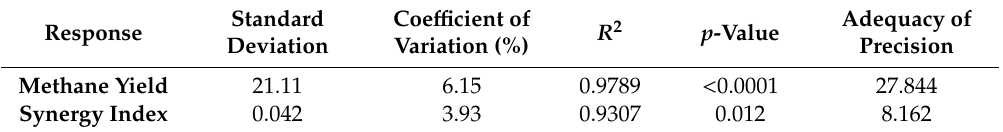
Figure 2. Methane yields ( A ) and synergy indices ( B ) determined on days 10, 20, and 30 of the BMP experiments. The CM: FW: PM mixing ratio (total solids basis) for each BMP run is given in parentheses below the corresponding run number. The red dashed line in panel ( B ) indicates where the synergy index is 1. Error bars indicate standard deviations ( n = 3). Table 3. Statistical significance of the response surface